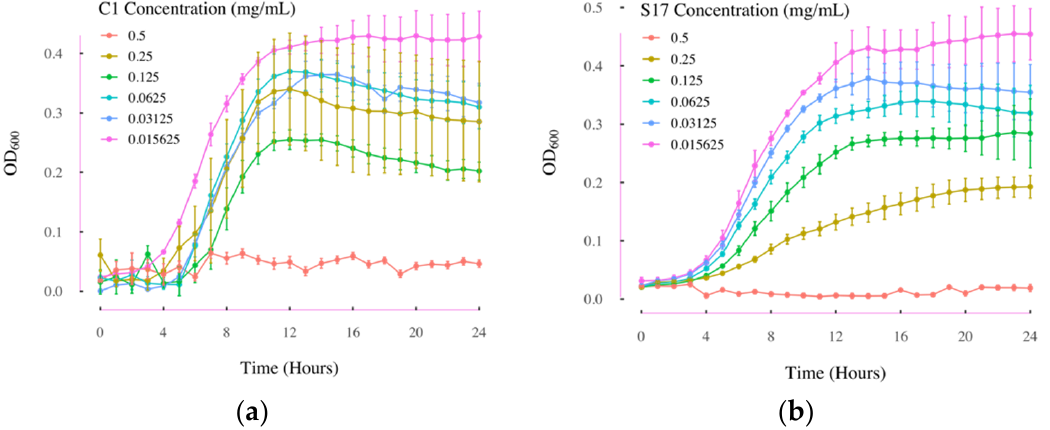
Figure 3. The growth curves of L. innocua over 24 h in MIC test. ( a ) Growth curves of L. innocua under different concentration of compound C1 treatment over 24 h; ( b ) growth curves of L. innocua under different concentration of compound S17 treatment over 24 h. C1: 2-[4-(dimethylamino)benzylidene]-N-nitrohydrazinecarboximidamide; S17: 2-Amino-5-bromobenzimidazole; OD 600 : the absorbance at 600 nm; n = 3; Error bars represent standard deviations.